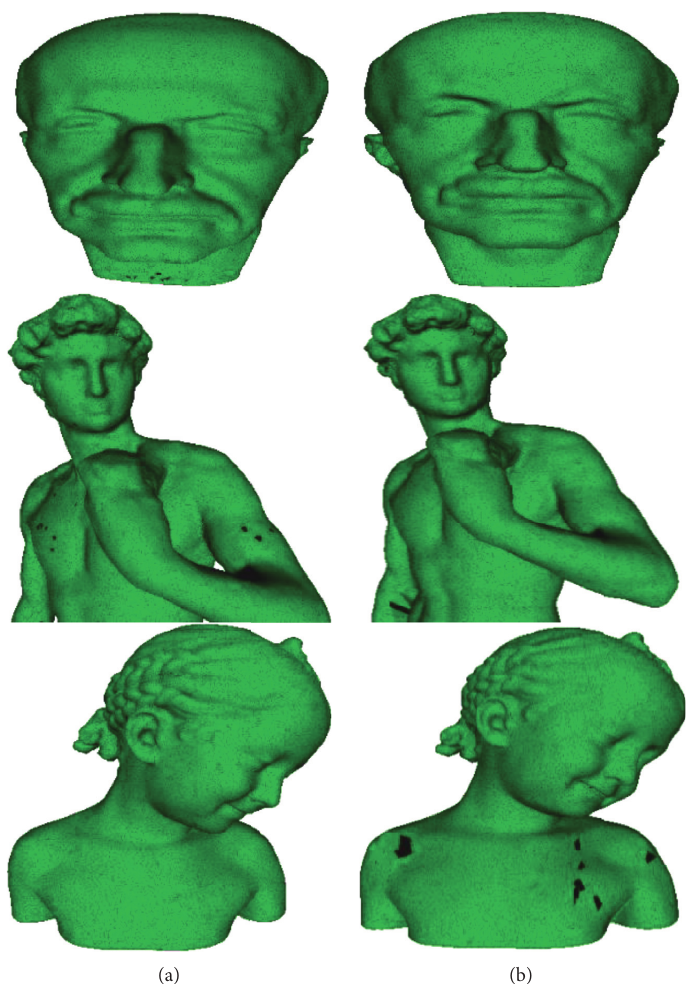
Figure 5: Various models simplified using the novel method. Left column: the original point clouds (triangulated). Right column: the simplified point sets